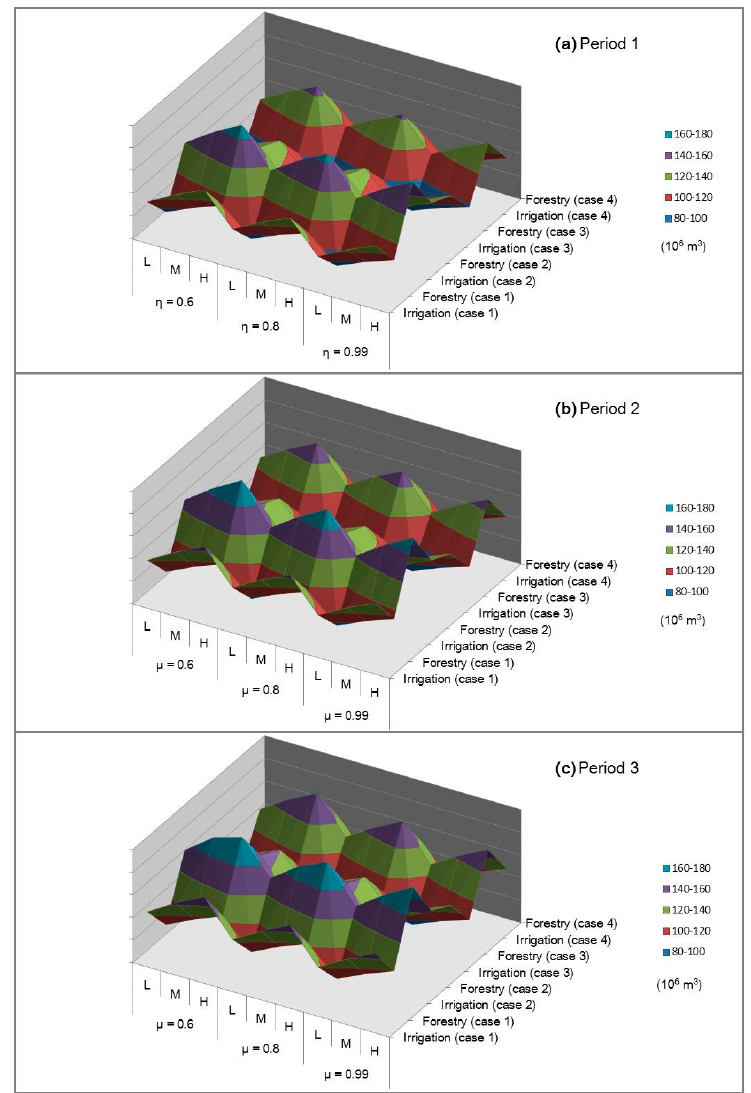
Figure 6. Optimal water allocations between crop and forest under cases when µ level is 0.99.